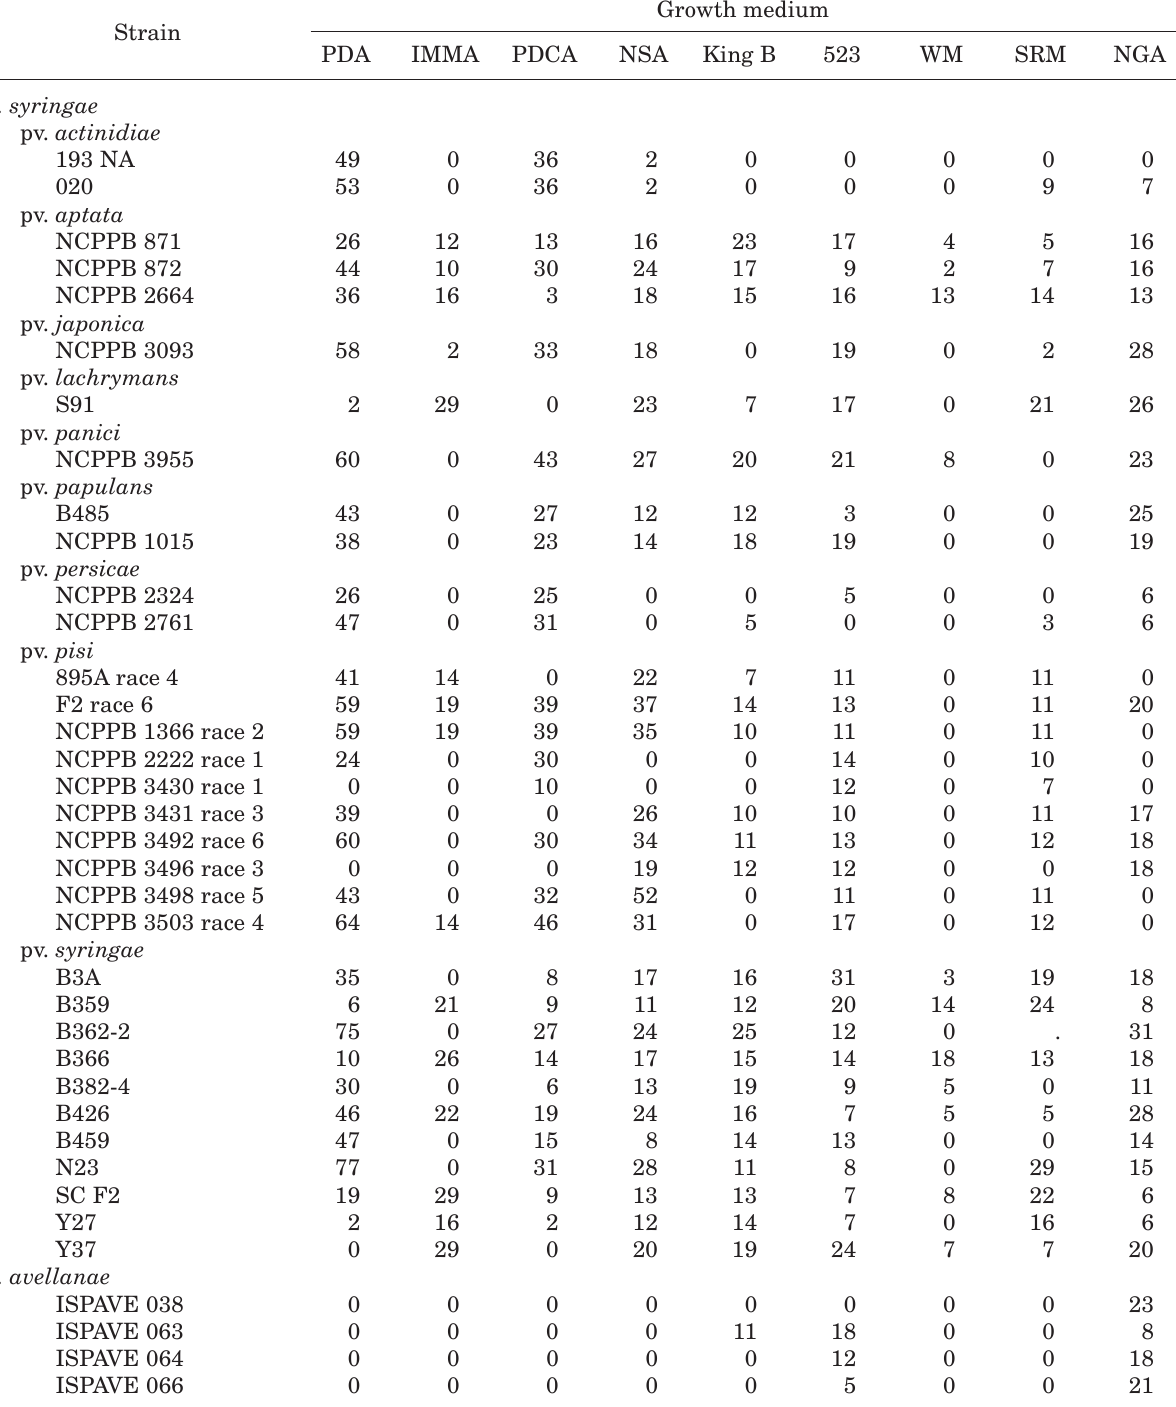
Table 2. Diameter (mm) of the inhibition zone produced by 33 strains of 9 pathovars of Pseudomonas syringae and 4 strains of P. avellanae tested on 9 media for antimicrobial activity against Bacillus